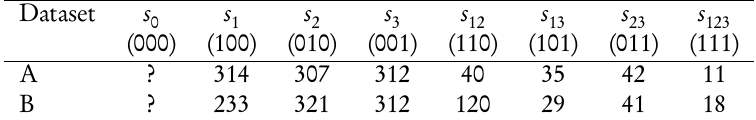
Capture profiles of simulated